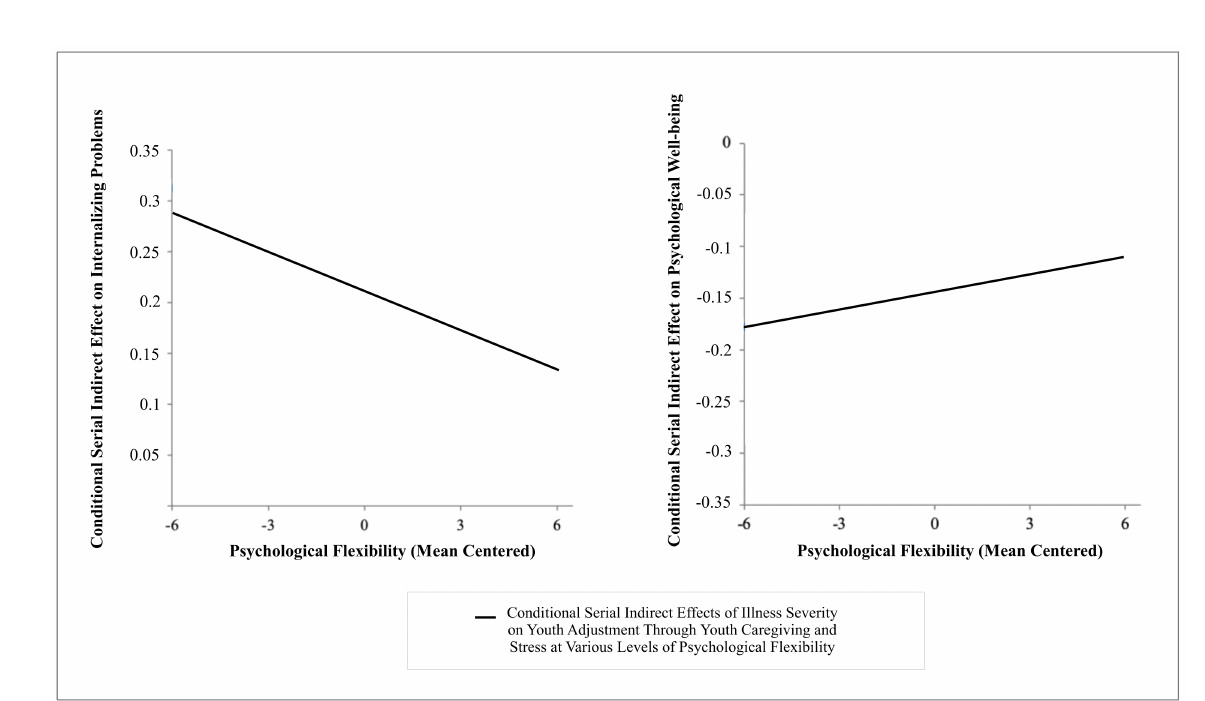
Figure 3. A visual representation of the linear functions relating psychological flexibility to the serial indirect effects of illness severity on internalizing problems and psychological wellbeing via youth caregiving and stress. Note. Results are depicted controlling for the control variables (age and gender) included in the moderated mediation